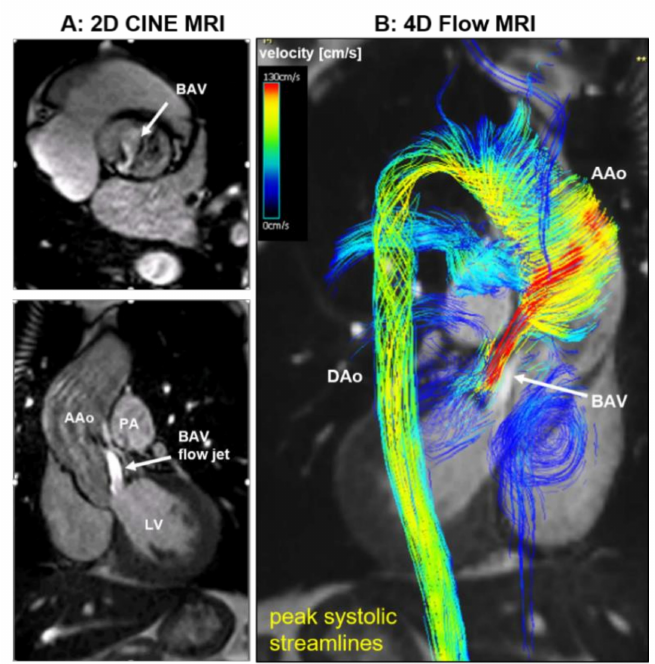
Figure 2. The 2D CINE ( A ) and 4D flow cardiovascular magnetic resonance (CMR) ( B ) in a 32-year old patient with bicuspid aortic valve (BAV, right-noncoronary (R-N) valve fusion pattern), aortic dilatation (Sinus of Valsalva / Mid Ascending Aorta diameter = 42 / 45 mm), moderate aortic valve stenosis (aortic valve area = 1.5 cm 2 ). A: 2D CINE MRI during peak systole shows limited BAV opening (top) and the associated outflow jet (bottom) B: 3D streamline visualization of systolic blood flow in the thoracic aortic as assessed by 4D flow CMR and shows a marked high-velocity (red color) valve outflow jet directed toward the anterior wall of the ascending aorta (AAo). Note the formation of a complex helix flow pattern in the entire AAo. In addition, 4D flow CMR provides full volumetric coverage of the thoracic aorta and flexible retrospective quantification of peak systolic velocities at multiple locations in the thoracic aorta. LV = left ventricle, PA = pulmonary artery, DAo = descending